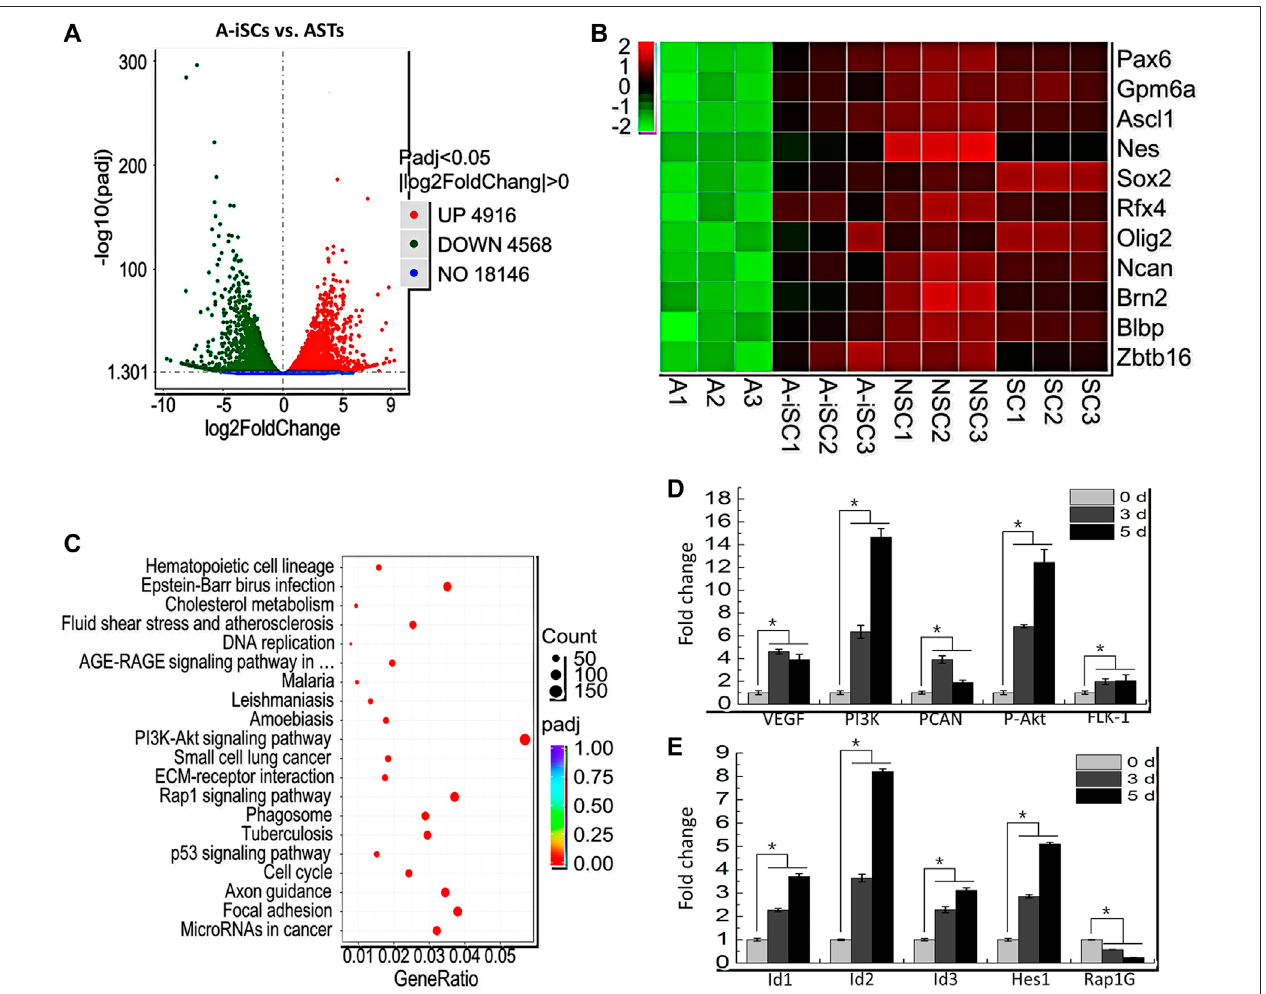
FIGURE 2 | (A) Volcano plot of differentiated genes between ASTs and A-iSCs. (B) Heat map of representative high-expression genes in A-iSCs compared to ASTs,P56-NPCs,andP0-NPCs. (C) PathwaysinvolvedinA-iSCscomparedwithASTsinKEGGanalysis. (D) RT-PCRanalysisofVEGF,PI3K,PCNA,P-Akt,andFLK-1 in A-iSCs at speci fi c time intervals. * p < 0.05. (E) RT-PCR analysis of Id1, Id2, Id3, Hes1, and Rap1G in A-iSCs at speci fi c time intervals. * p <